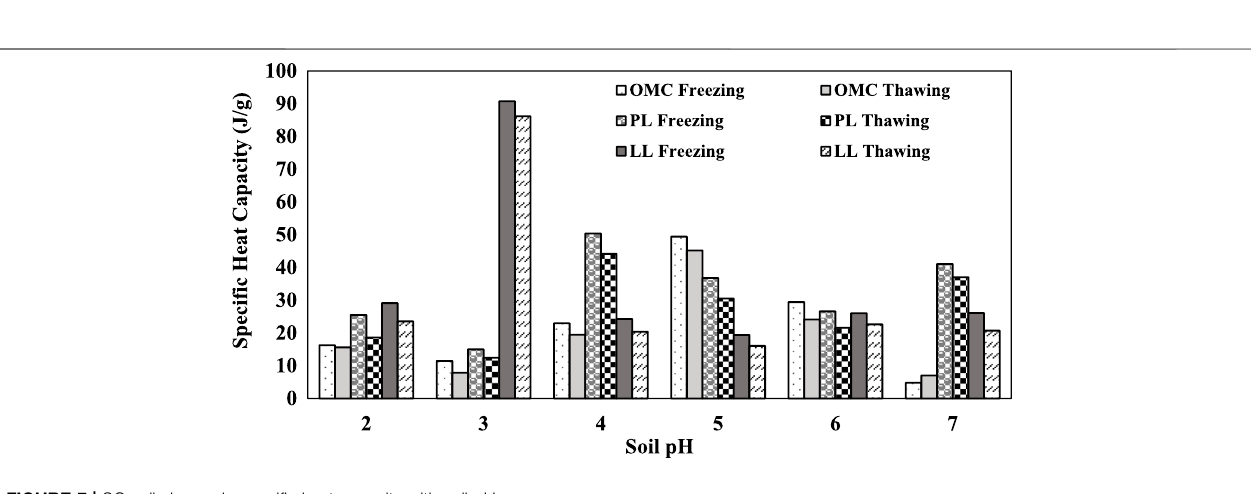
FIGURE 7 | SC soil change in speci fi c heat capacity with soil